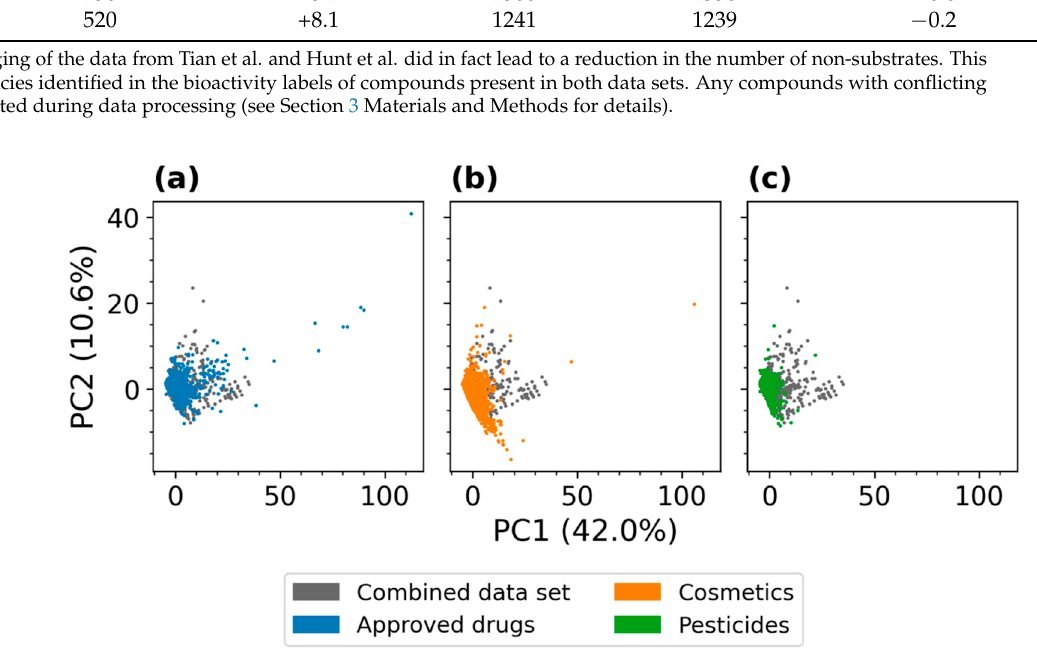
Figure 1. Principal component analysis (PCA) scatter plots comparing the chemical space of the core data set with that of the reference data sets of ( a ) approved drugs, ( b ) cosmetic ingredients, and ( c ) pesticides. The percentages reported in the axes labels denote the proportion of variance explained by the respective principal component. The principal components are calculated from 44 physically meaningful 2D molecular descriptors selected previously [23].